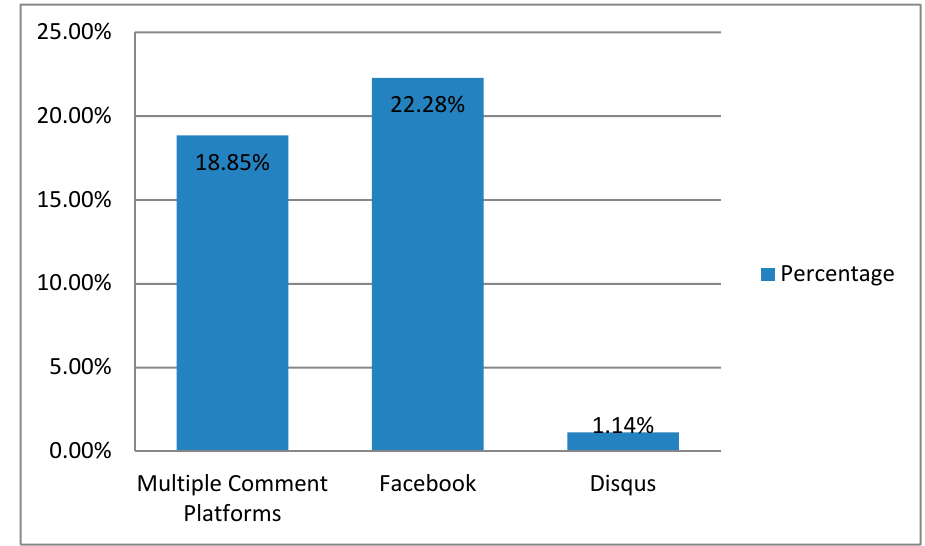
Figure 5. The Results of the Study for the Greek News Websites for the Commenting Platforms (n = 175).